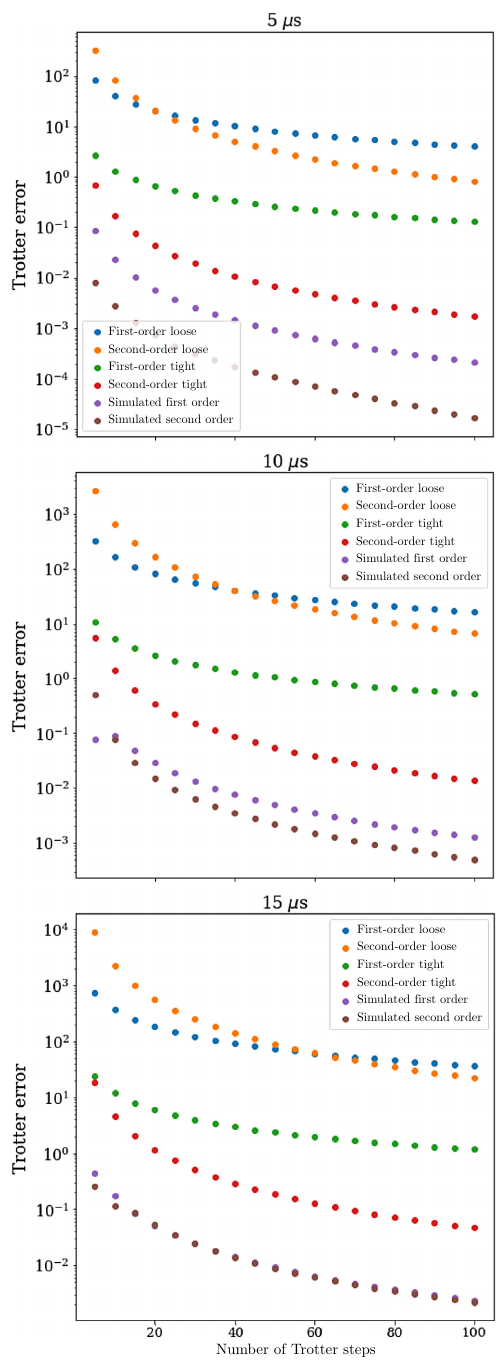
FIG. 5. The Trotter error in the three-qubit F- μ + -F system. The error bounds used are described in the main text. In all of these results, we use a magnitude ordering of Hamiltonian terms in the product formula; the terms with the largest coefficients are placed first in the Trotter